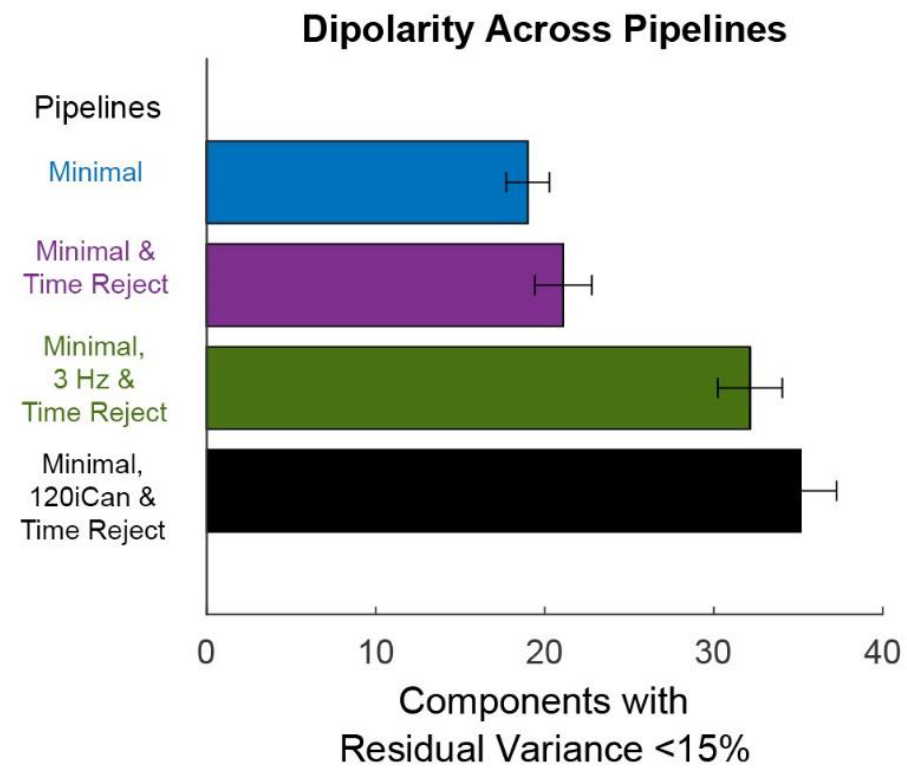
Figure 7. Mean +/ − SEM of dipolarity shows the quality of the ICA decomposition. Dipolarity is measured as the number of components with residual variance less than 15% after fitting dipoles with a three-layer boundary element model of the standard MNI brain template. The Minimal pipe- line (blue) includes basic preprocessing (filtering, channel rejection, interpolation, average re-refer- encing). The Minimal & Time Reject pipeline (purple) rejects bad time windows using clean_arti- facts after minimal cleaning. The Minimal, 3 Hz & Time Reject pipeline (green) filters the scalp chan- nels after minimal cleaning and with subsequent time window rejection (substituting for iCan- Clean). The Minimal, 120iCan, & Time Reject pipeline (black) uses all noise electrodes to clean scalp